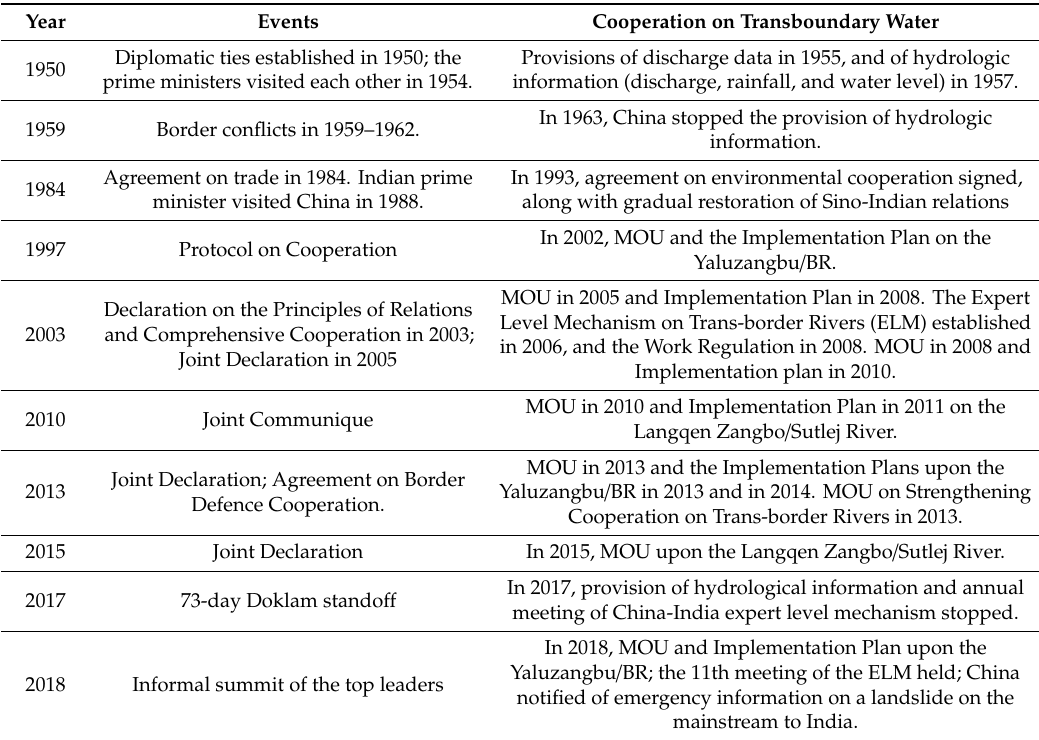
Table 2. China-India cooperation process on transboundary